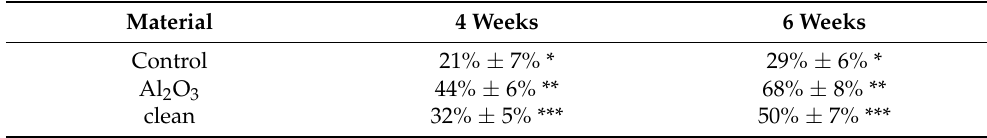
Table 7. Region of interest (ROI) bone growth for different types of Ti dental implant surfaces and after 4 and 6 weeks of implantation. Statistical differences for each column are indicated by single asterisk and double or triple asterisk symbols ( p <